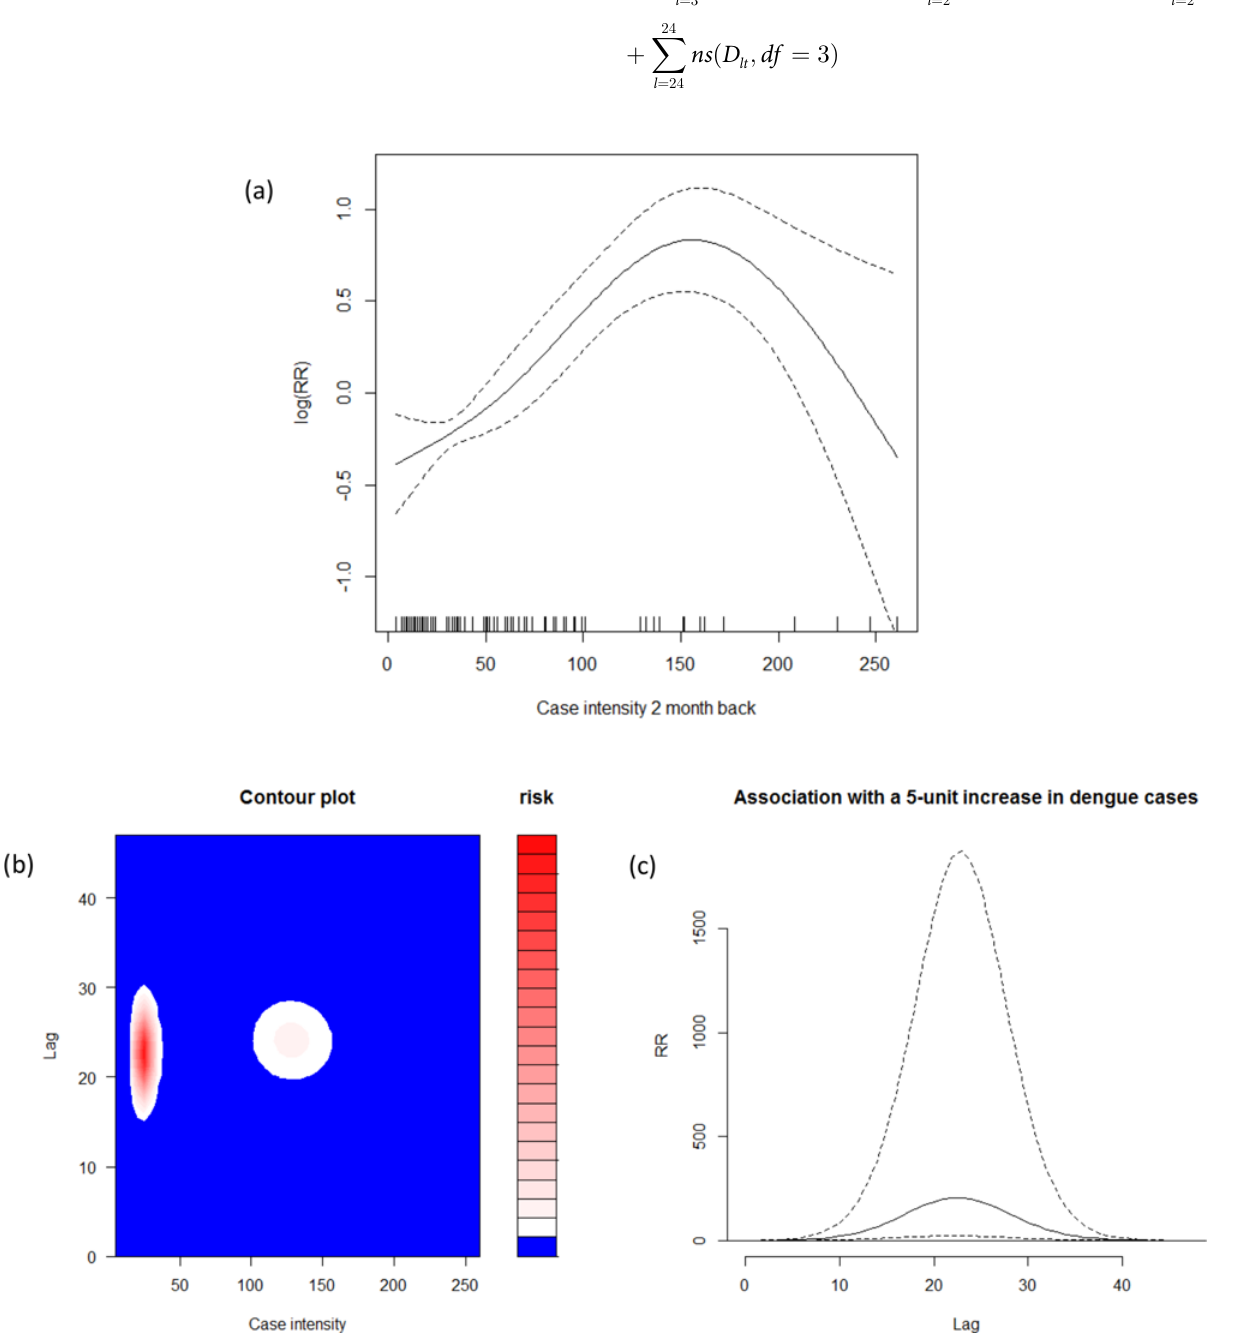
Fig 4. Relationship between Autoregressive Lags and Dengue Counts. Upper panel shows (a) relative risks of dengue cases as functions of dengue surveillance at 2-month lag times. Lower panel shows (b) the relation between case intensity and dengue risk categories at all lag months; and (c) the risk in each future month following an increase of 5 dengue cases in a specific